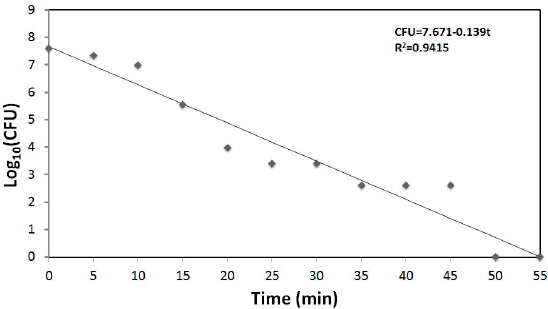
Figure 4. Kinetics of bacterial killing on thin copper films. A suspension of Staphylococcus aureus was deposited on a thin copper film supported by a stainless steel support under ambient conditions (22 °C). Samples were taken periodically and survivors were quantified by culturing serial decimal dilutions on LB agar plates (unpublished results from the authors).